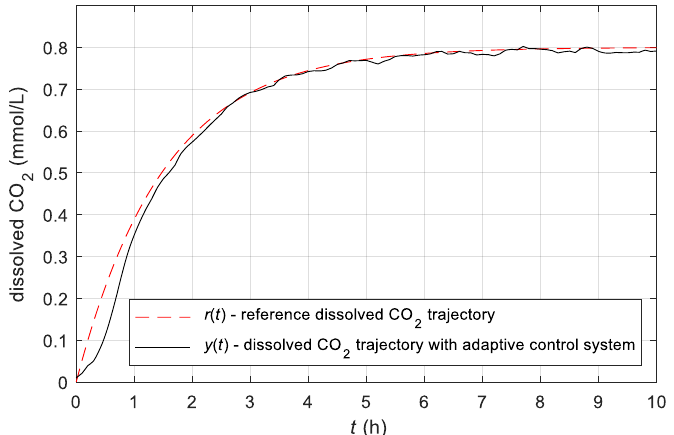
Figure 10. Time responses of the reference and actual dissolved CO 2 concentration of the original fermentation process in the batch bioreactor; simple adaptive control was used; data of the controlled original fermentation process with fully activated kefir grains are shown in Table 2, the adaptation mechanism parameters in (23) and (24).